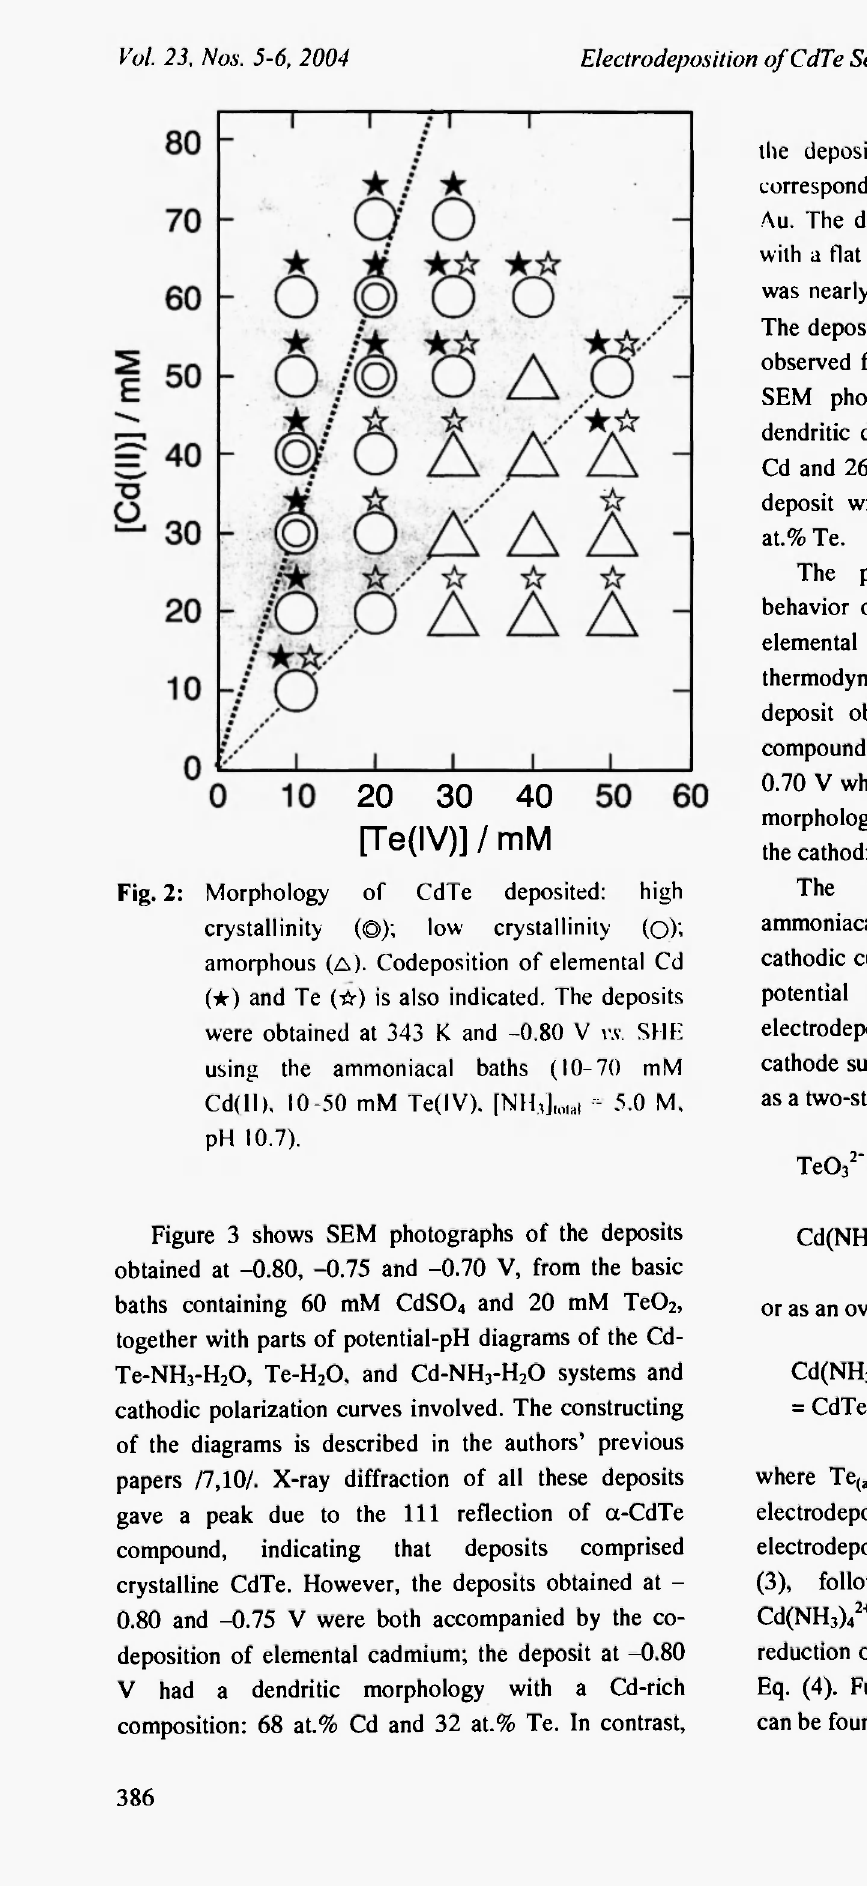
20 30 40 [Te(IV)] / mM Fig. 2: Morphology of CdTe deposited: high crystallinity (@); low crystallinity (o); amoφhous (Δ). Codeposition of elemental